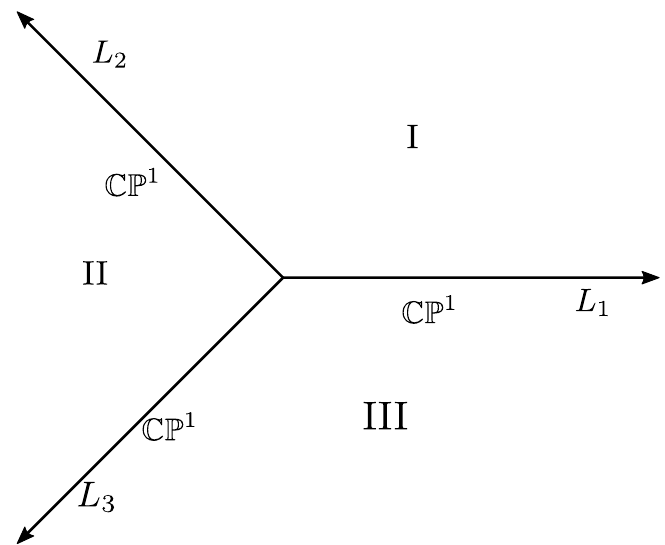
M 22 = 0 ( M 11 < 0), (cid:0) U(1) preserving (cid:2)